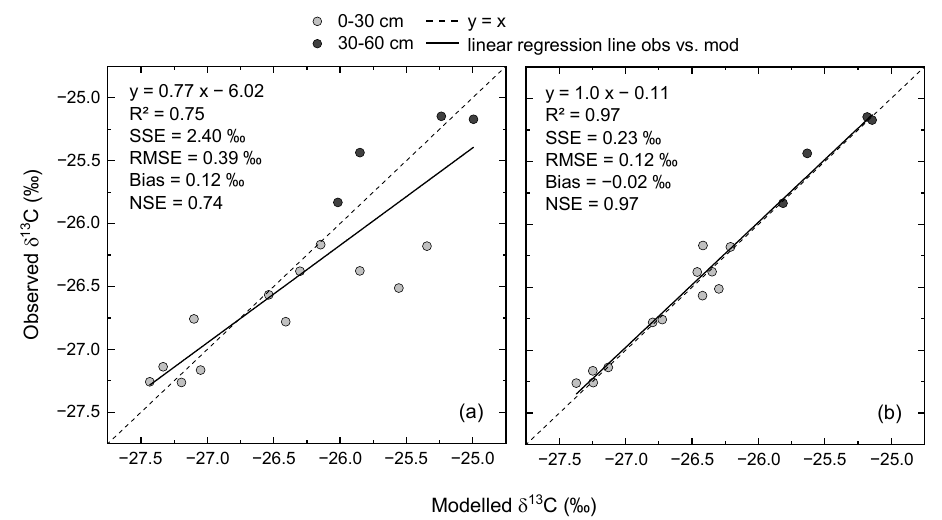
Figure 4. Scatterplots of measured vs. modelled δ 13 C values of soil organic carbon in the topsoil (0–30 cm) and subsoil layer (30–60 cm) using pre-defined parameter values ( a ) and after parameter optimization ( b ). RMSE = root mean squared error, NSE = Nash–Sutcliffe model efficiency. For comparison: the SD of the wheat flour as a blind control was 0.11‰. Each data point is the mean of four plots.